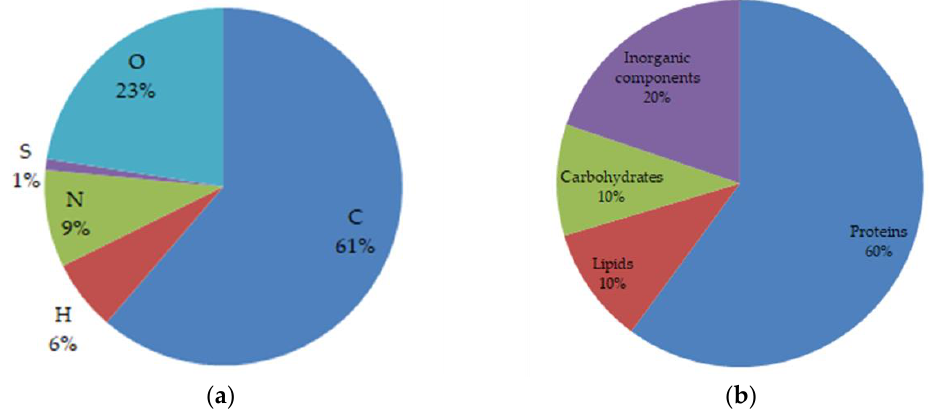
Figure 1. Elemental composition ( a ) and biochemical composition, wt.% ( b ) of the feedstock ( A. platensis rsemsu Bios ).